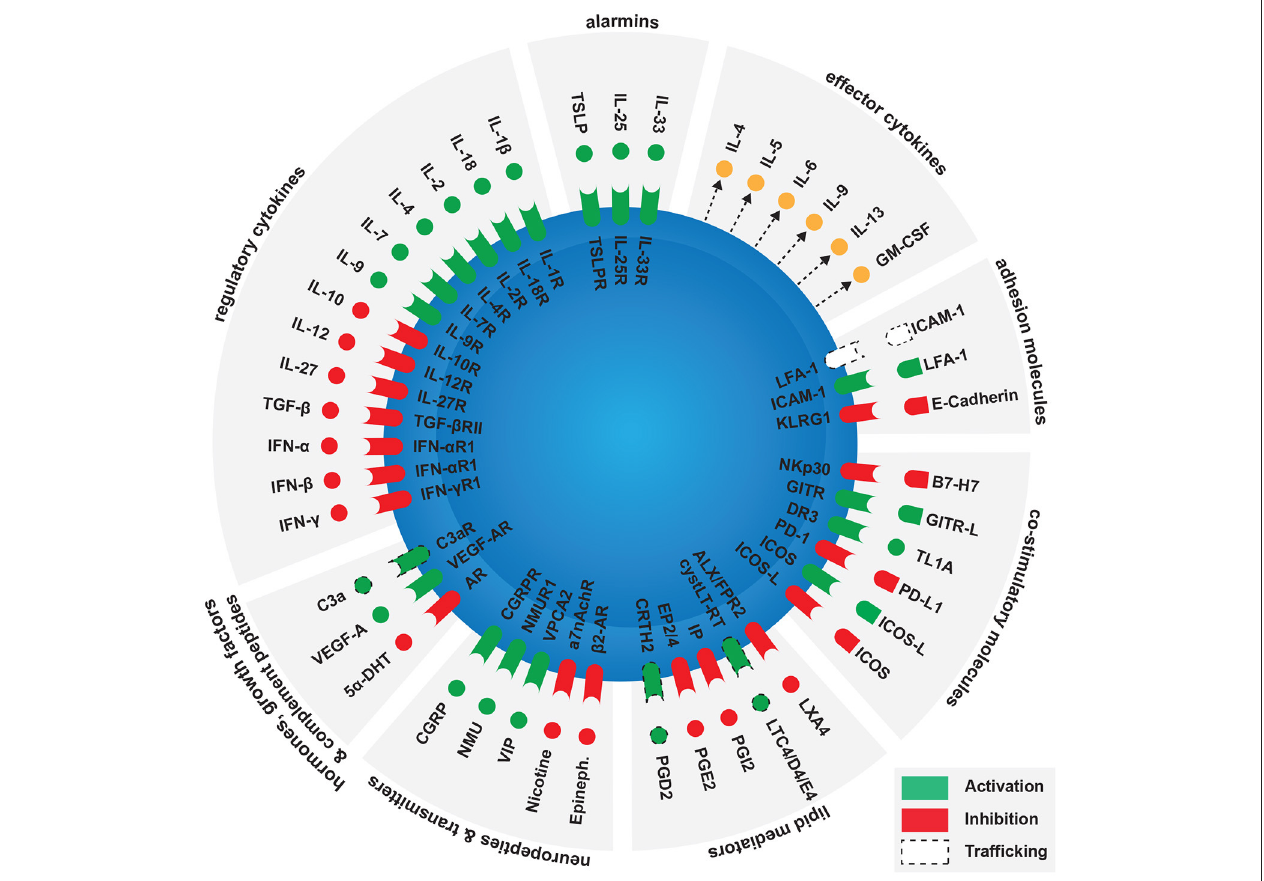
FIGURE 1 | Factors modulating ILC2 activation in the context of allergy. Main ILC2 activators are alarmins released by epithelial cells, as activated ILC2s release various effector cytokines including IL-4, IL-5, IL-6, IL-9, IL-13, and GM-CSF. Several groups of molecules can enhance or inhibit ILC2 activation. These include contact independent pathways such as regulatory cytokines, hormones, growth factors, complement peptides, neuropeptides, neurotransmitters, and lipid mediators. Contact-dependent pathways include co-stimulatory and adhesion molecules.